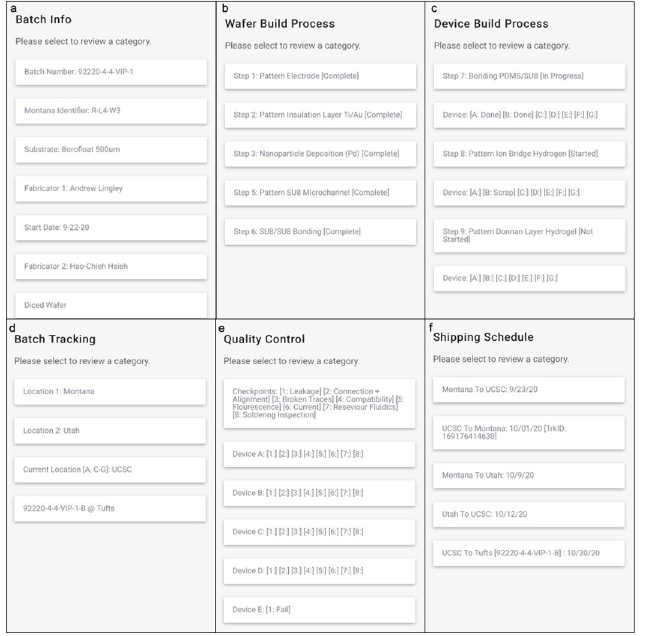
Fig 3. Categoric data points that QR code system tracks. (a) Batch Information, (b) Wafer Build Process, (c) Device Build Process, (d) Batch Tracking, (e) Quality Control, & (f) Shipping Schedule. Fig 3 provided through courtesy of QR Code